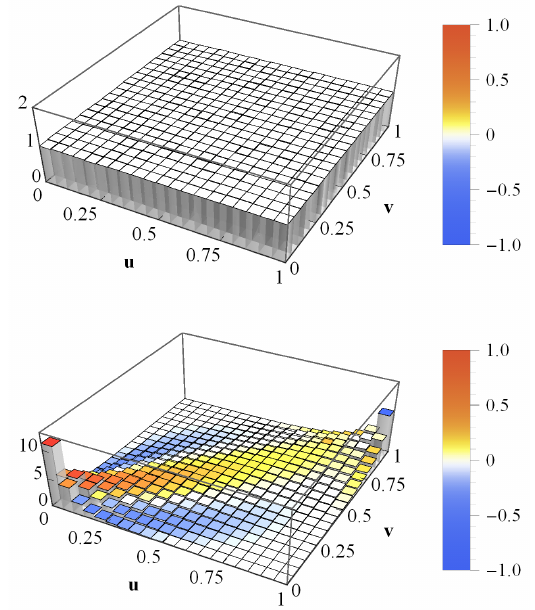
Figure 11. Average loss copula histograms for homogeneous portfolios with vanishing average asset correlations c = 0. The asset values are multivariate log-normal ( N multivariate heavy-tailed ( N eff = 5) in the bottom figure. The color bar indicates the local deviations from the corresponding Gaussian copula. Taken from (Sicking et al.